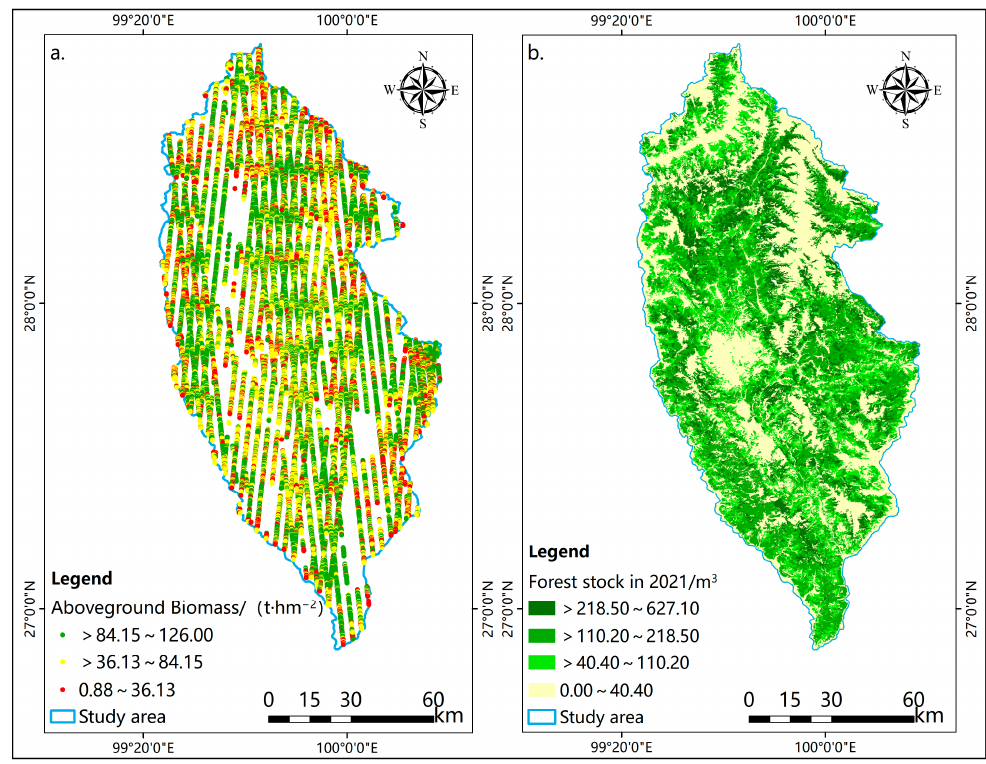
Figure 8. Spatial distribution of AGB of ICESat-2 footprints and forest stock in 2021. ( a ) Footprints AGB. ( b ) Forest stock in 2021.